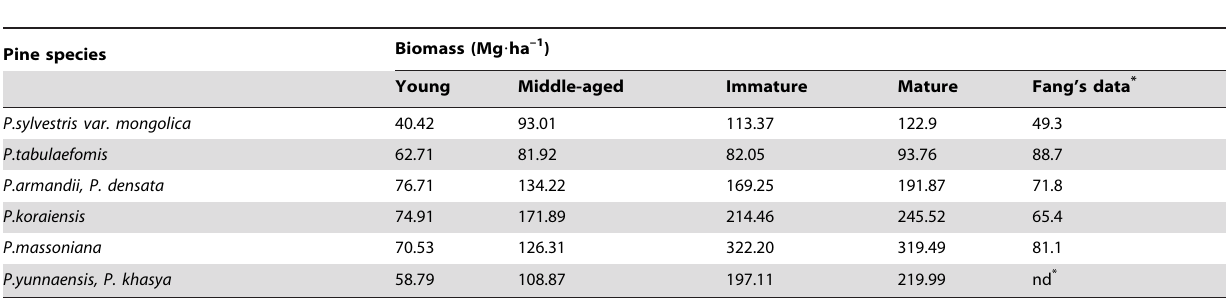
* nd indicates that the results were not determined at these sites.